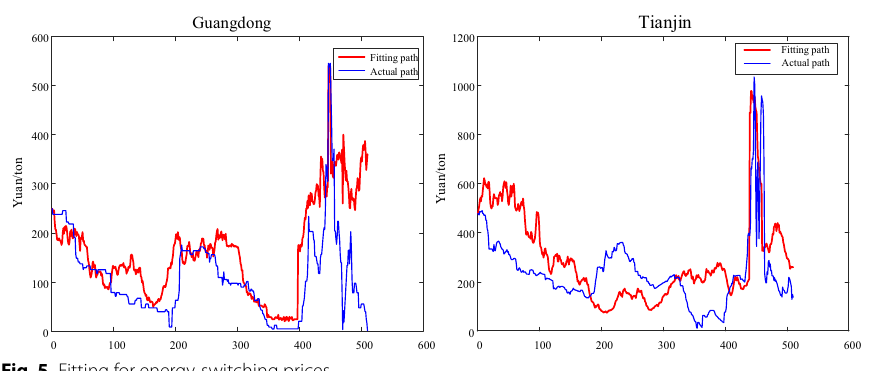
Fig. 5 Fitting for energy-switching